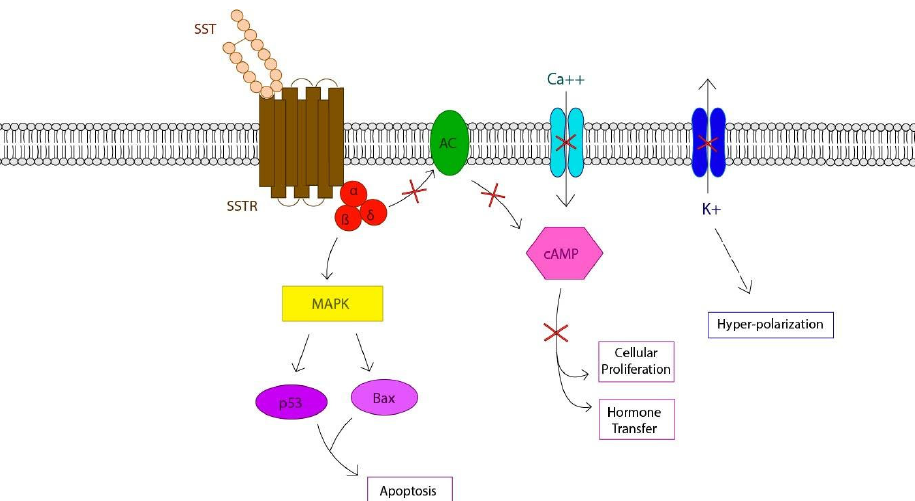
Figure 2. Representation of the ligand–receptor interaction between SST and SSTR (lock and key), which sets off a cascade of signals inside the cell. Inhibition of AC activity and Ca2+ influx results in cell cycle arrest and halts hormone transfer as indicated. Accumulation of K+ inside the cell causes hyper-polarization and pauses communicative activity. Apoptosis, or cell death, is favored. X= cascade signaling which is blocked when SST interacts with SSTR.